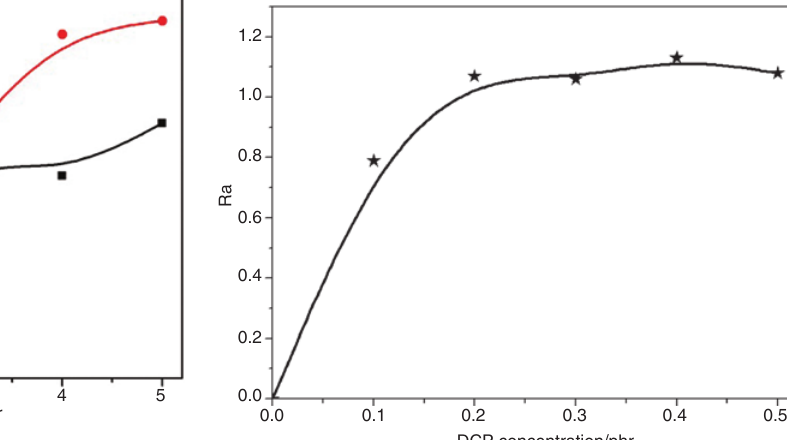
Figure 6 Effect of GMA concentration on the GD by elemental analysis. Figure 7 Effect of initiator concentration on the GD.